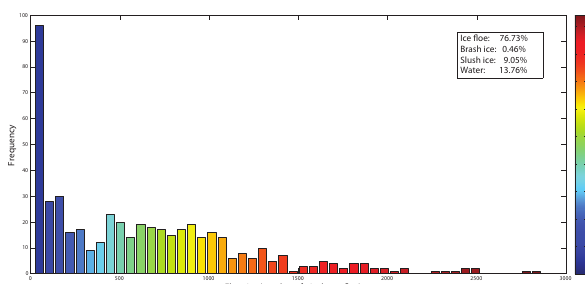
Figure 10: Floe size distribution histogram obtained from Figure